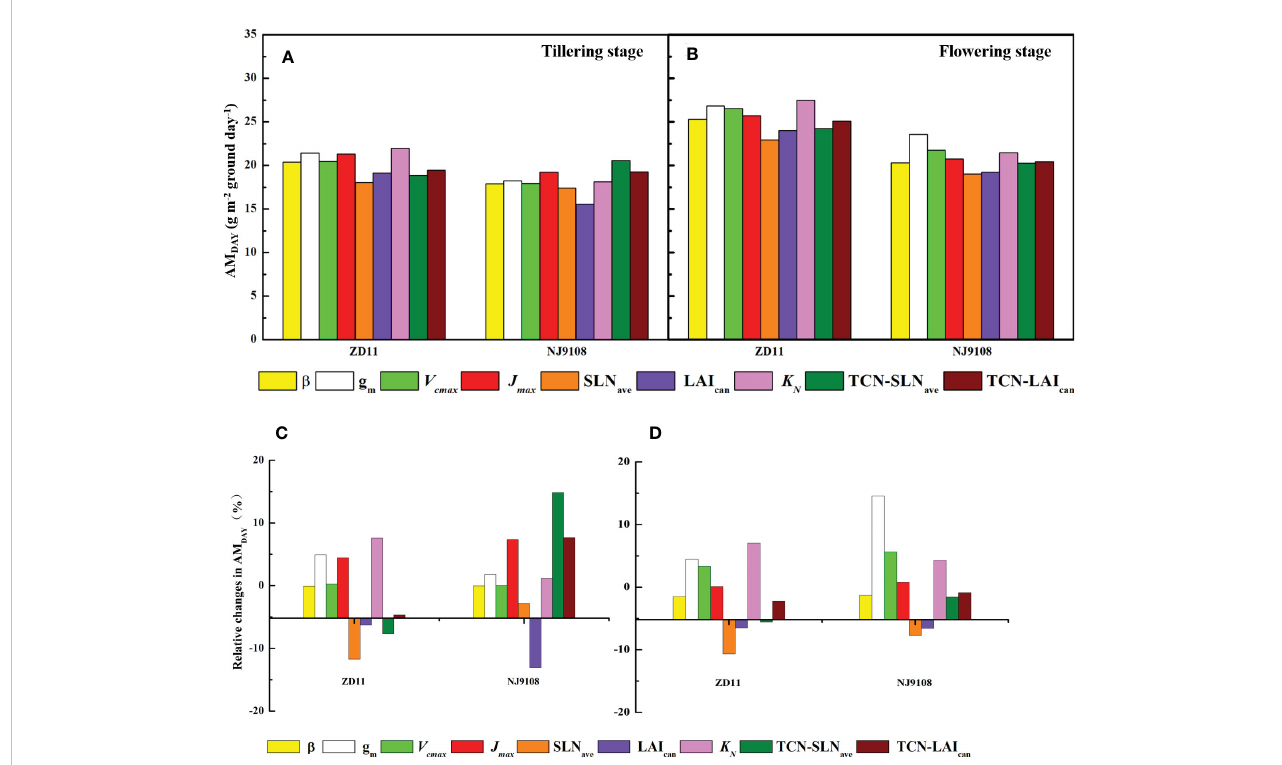
FIGURE 6 AM DAY based on replaced parameters (A, B) and percentage change in AM DAY (C, D) for different rice cultivars during tillering (A, C) and fl owering stage (B, D) . The simulated values based on replaced parameters of YLY5867 or YLY3218 were compared with counterparts based on observed parameters. Replaced parameters include canopy average leaf inclination relative to the horizontal ( b ), mesophyll conductance ( g m ), maximum carboxylation rate ( V cmax ), maximum electron transfer rate ( J max ), average canopy nitrogen concentration per unit leaf area (SLN ave ), canopy leaf area index (LAI can ), canopy photosynthetic nitrogen extinction coef fi cient ( K N ), total canopy nitrogen concentration through improvement in SLN ave (TNC-SLN ave ), total canopy nitrogen concentration through improvement in LAI can (TNC-LAI can